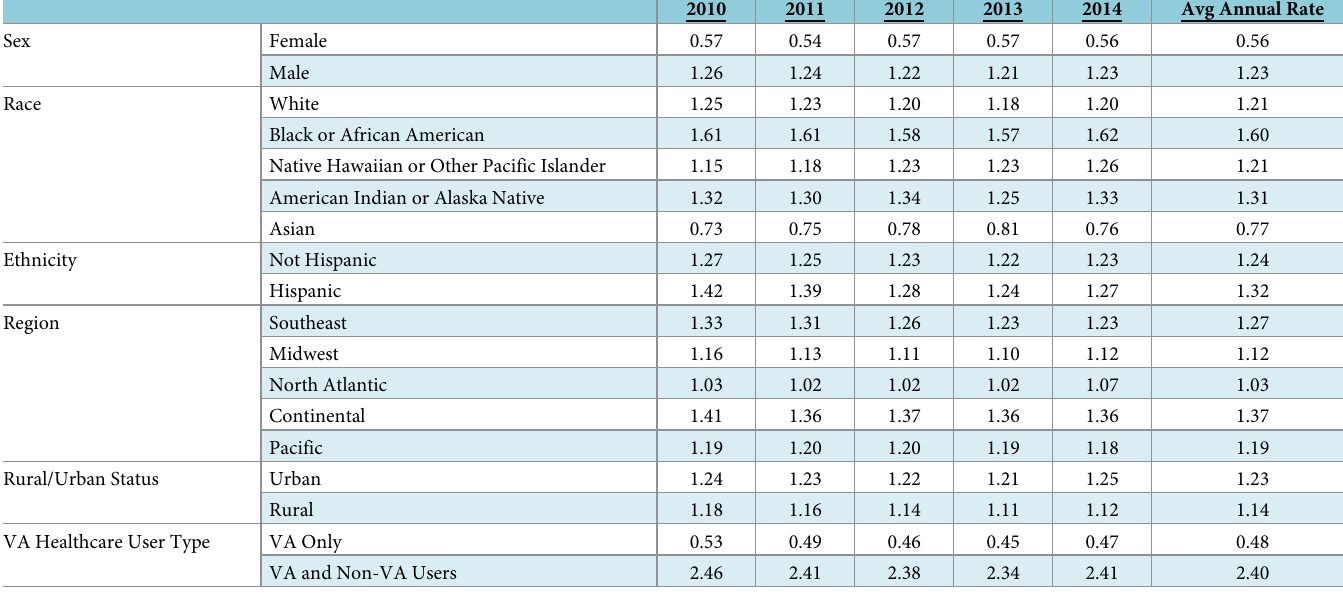
Table 2. Age-adjusted annual rates of hospitalization (per 100 veterans) for one or more of the top 5 cardiovascular conditions.